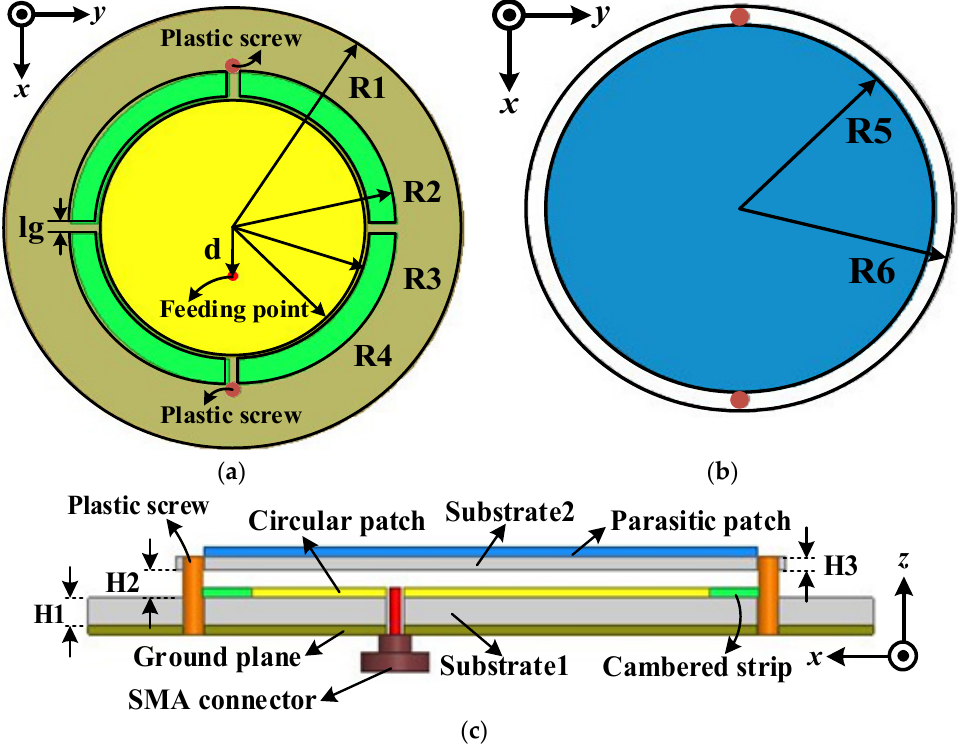
Figure 1. Geometry of the proposed patch antenna: ( a ) top view of Substrate 1; ( b ) top view of Substrate 2; ( c ) side view of the proposed antenna. R1 = 48, R2 = 32, R3 = 27, R4 = 26.25, R5 = 33, R6 = 38, d = 9.8, lg = 4, H1 = 1.5, H 2 = 0.5, H3 = 1.1 (all dimensions in mm).